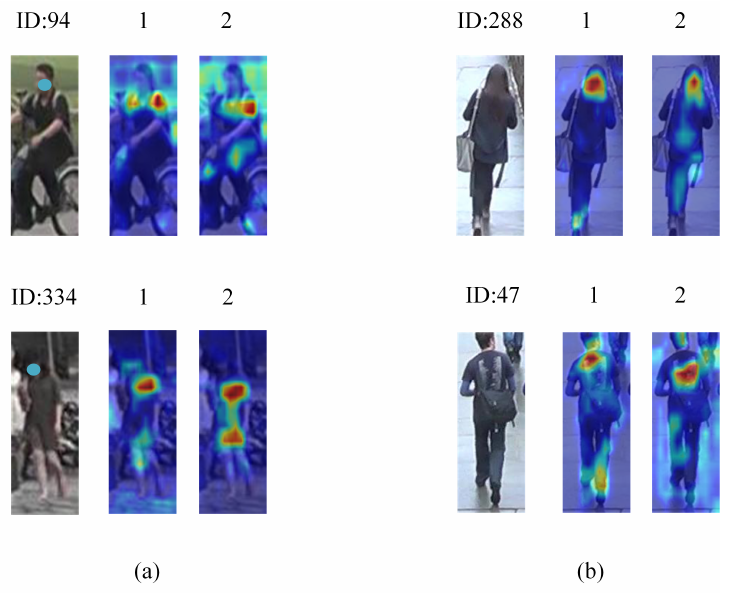
Figure 13. Comparison of heat map results of the two networks. “1” is the heat map result of the baseline (without local branch, non-local, IBN, and attribute); “2” is the heat map result of the method proposed in this paper. ( a ) ID 94, 934 on Market-1501; ( b ) ID 288, 47 on DukeMTMC-reID.